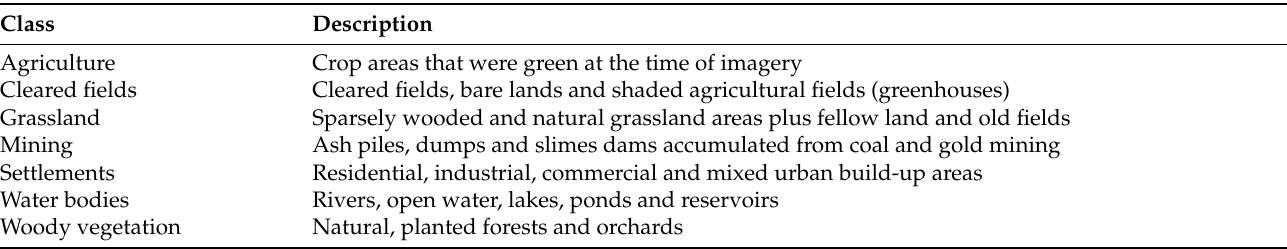
Table 1. Land cover classes used in this study.